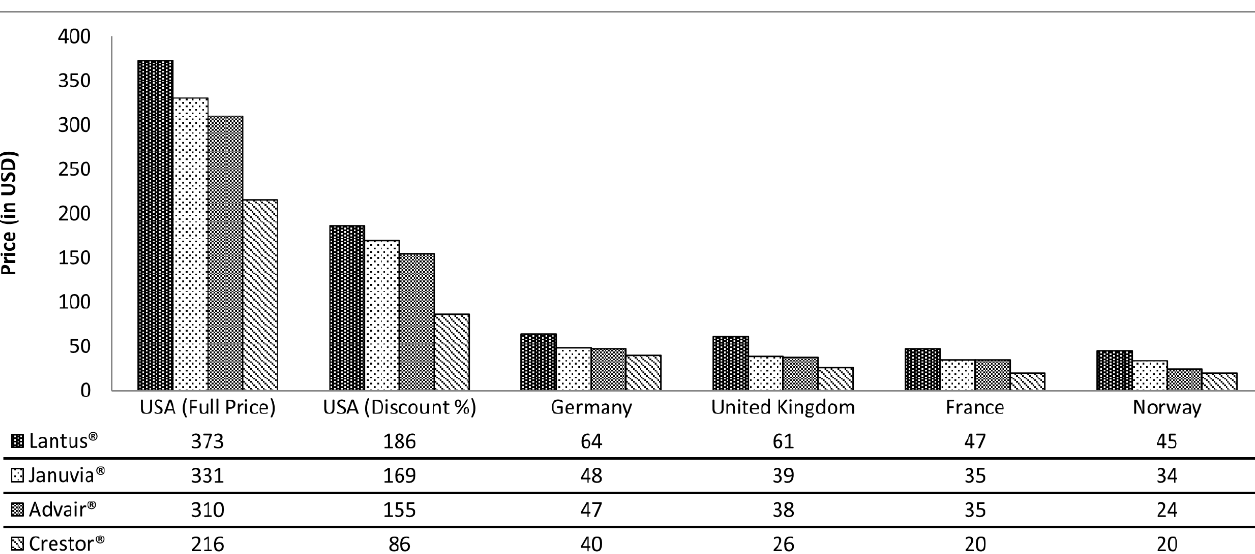
Figure 5. Comparison between four different drug prices, before and after an estimated discount applied in the US market, compared with the price set in four European countries [19].